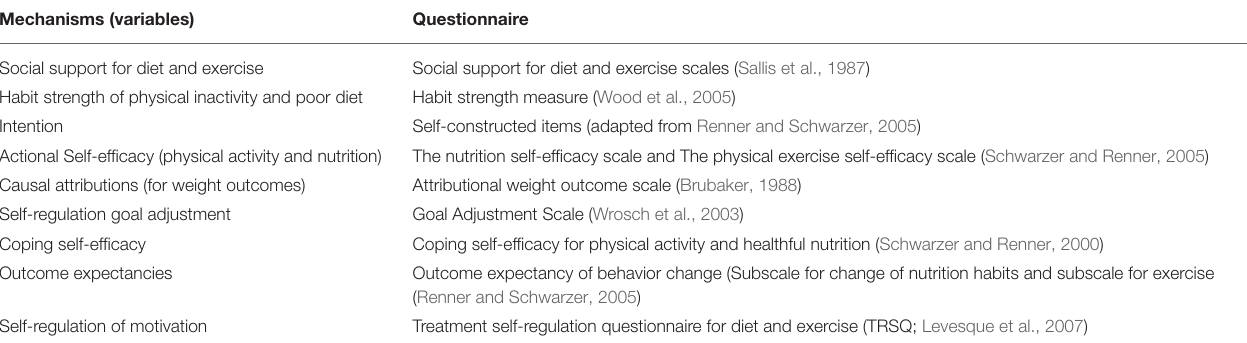
TABLE 3 | Overview of assessments that will be used in order to evaluate the behavior modification program. Mechanisms